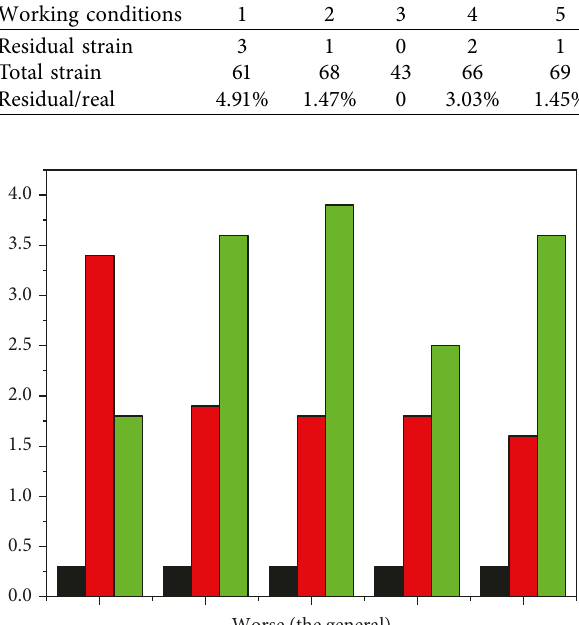
Figure 3: Total deflection under each working condition.